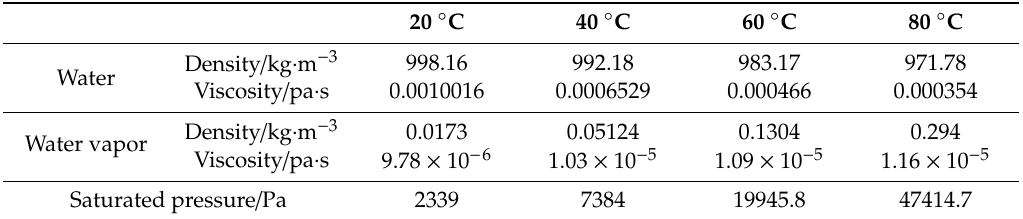
Table 2. Properties of water and water vapor.